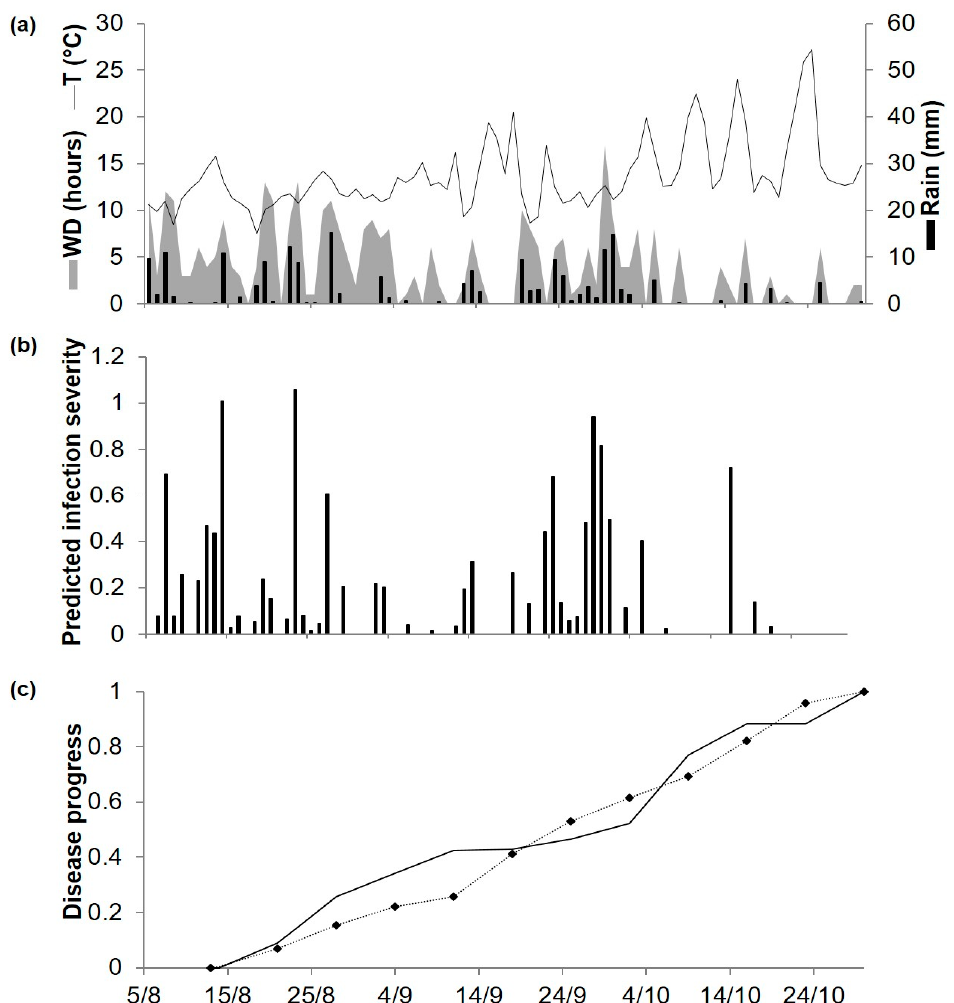
Figure 4. Predicted and observed disease progress (Ascochyta blight) on cv. Kaniva at the experimental field at the University of Adelaide’s Waite Campus, Australia, in 1996. ( a ) Weather variables: air temperature (T, °C, solid line), rainfall (Rain, mm, black bars), and leaf wetness duration (WD, hours, grey area). ( b ) Bars represent the infection severity predicted by the model. ( c ) Solid line represents the accumulated infection severity predicted by the model and rescaled to the final value of the year; the dotted line represents the observed Ascochyta blight severity rescaled to the final value of the year (71%).